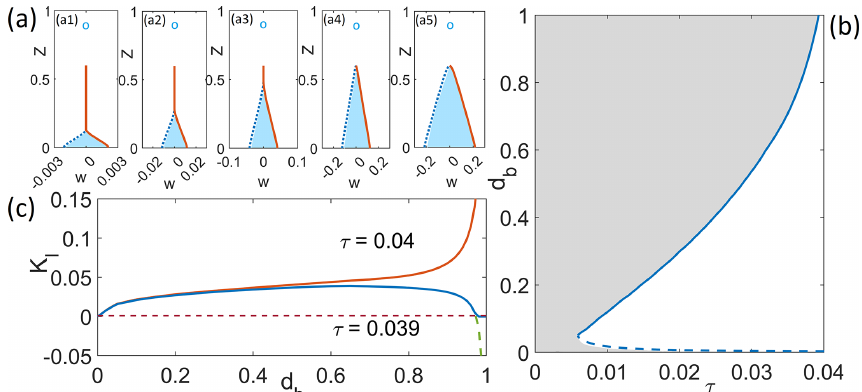
Figure 8. (a) Crack opening w(z) computed with the contact condition, at d b = 0 . 6 for τ = 0 . 01 (a1) , τ = 0 . 02 (a2) , τ = 0 . 03 (a3) , τ = 0 . 04 (a4) and τ = 0 . 05 (a5) , with the same plotting scheme as Fig. 3c; water level as indicated by the circle is sea level. (b) Bifurcation diagram for the basal crack for κ = 0 . 001, with the same plotting scheme as Fig. 6 except that there is now a single boundary curve since there is no hydrological parameter. (c) Stress intensity factor versus basal crack length for τ = 0 . 039 and τ = 0 . 04. The dashed green line shows the result for τ = 0 . 039 without the contact condition. Calving occurs when K I changes (under changes in τ from being zero to diverging to +∞ near d = 1) and is independent of the stress intensity factor as a b